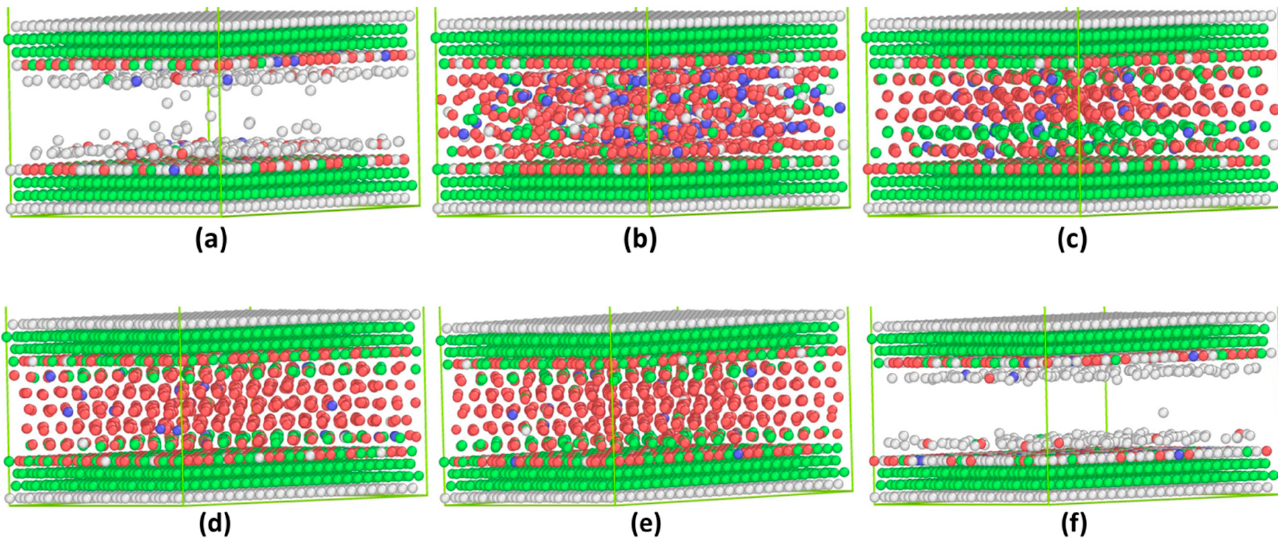
Figure 8. The GCMC snapshots of the atomic configurations of the adsorption-desorption isotherms for argon molecules confined between two incommensurate contacts at 85 K for n = 5 monolayer thickness. Adsorption: ( a ) µ = − 2.33 kcal/mol, ( b ) µ = − 2.32 kcal/mol, and ( c ) µ = − 2.15 kcal/mol. Desorption: ( d ) µ = − 2.15 kcal/mol, ( e ) µ = − 2.51 kcal/mol, and ( f ) µ = − 2.515 kcal/mol.